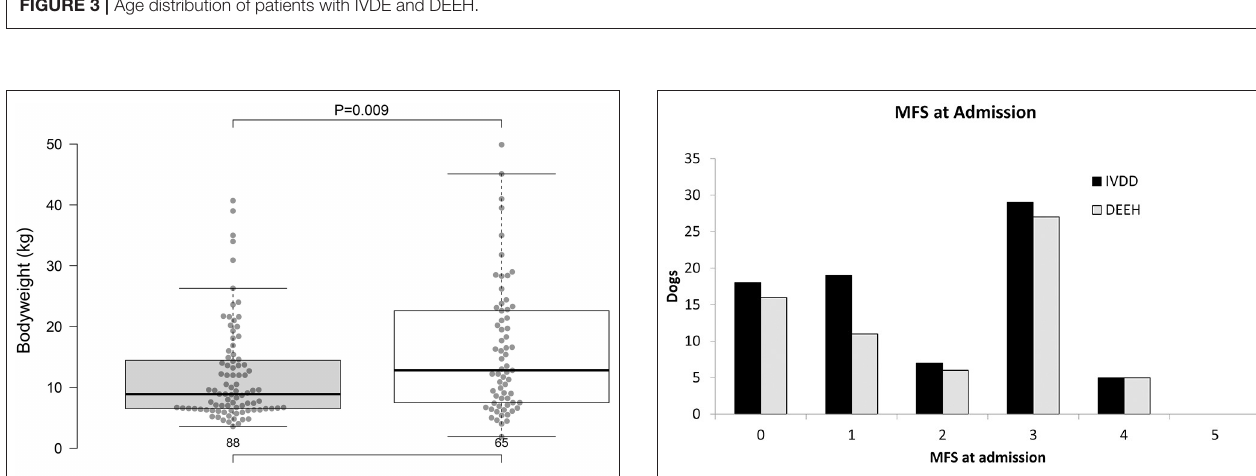
FIGURE 3 | Age distribution of patients with IVDE and DEEH.